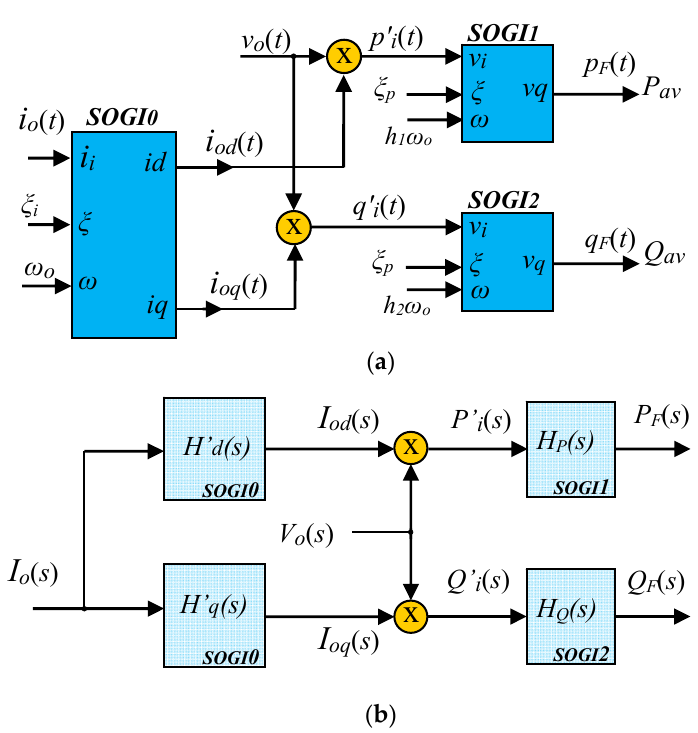
Figure 6. Proposed P–Q calculation algorithm scheme: ( a ) proposed algorithm scheme consisting of pre-filtering of the current, with only a SOGI, and a SOGI-LPF stage for each of the instantaneous powers calculated; ( b ) frequency-domain analytical representation for the proposed algorithm.